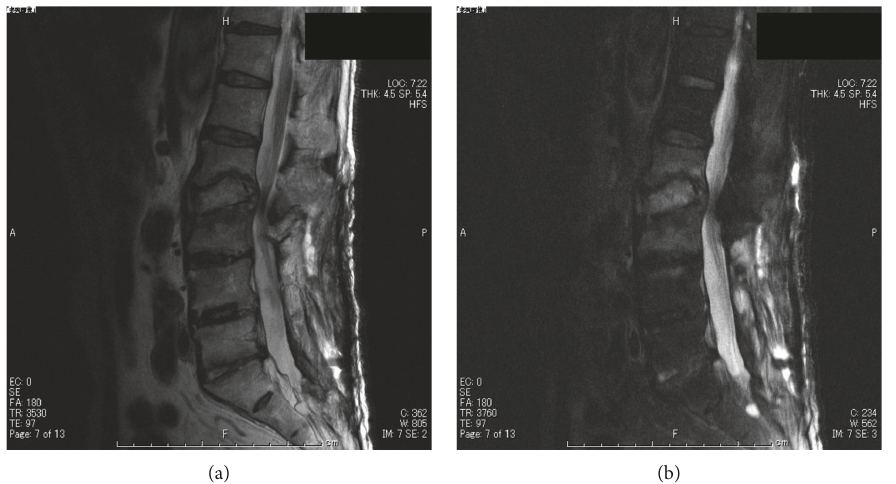
Figure 2: Case 1: plain sagittal T2-weighted (a) and gadolinium-enhanced T1-weighted (b) MRI showed the presence of an abscess at the L2- 3 level after removal of the